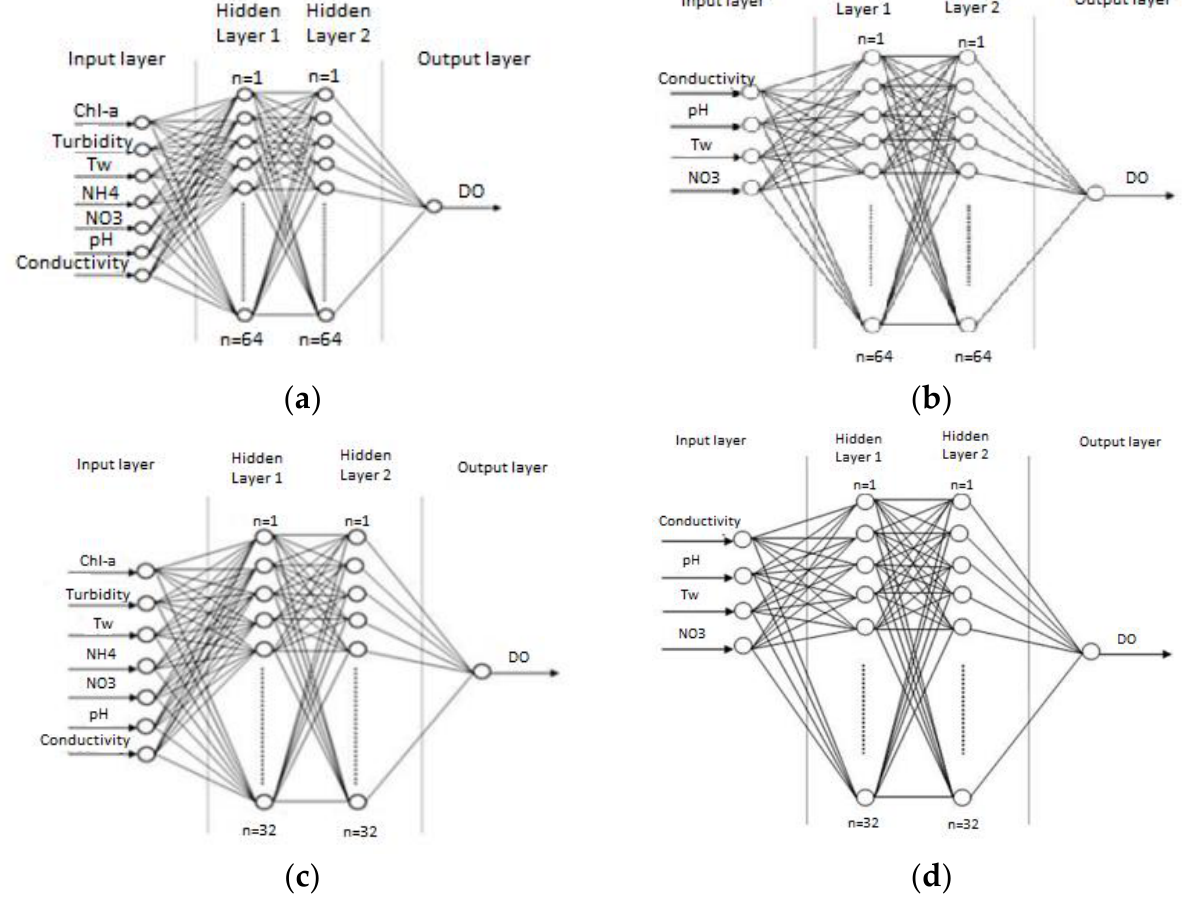
Figure 2. Different structures of DO models: ( a ) 7-64-64-1 for Gkiole, Psaradika, and Toichio stations and 6-64-64-1 for Stavros station, where NH 4 parameter is not available; ( b ) 4-64-64-1 for all stations; ( c ) 7-32-32-1 for Gkiole, Psaradika, and Toichio stations and 6-32-32-1 for Stavros station, where NH 4 parameter is not available; ( d ) 4-32-32-1 for all stations;